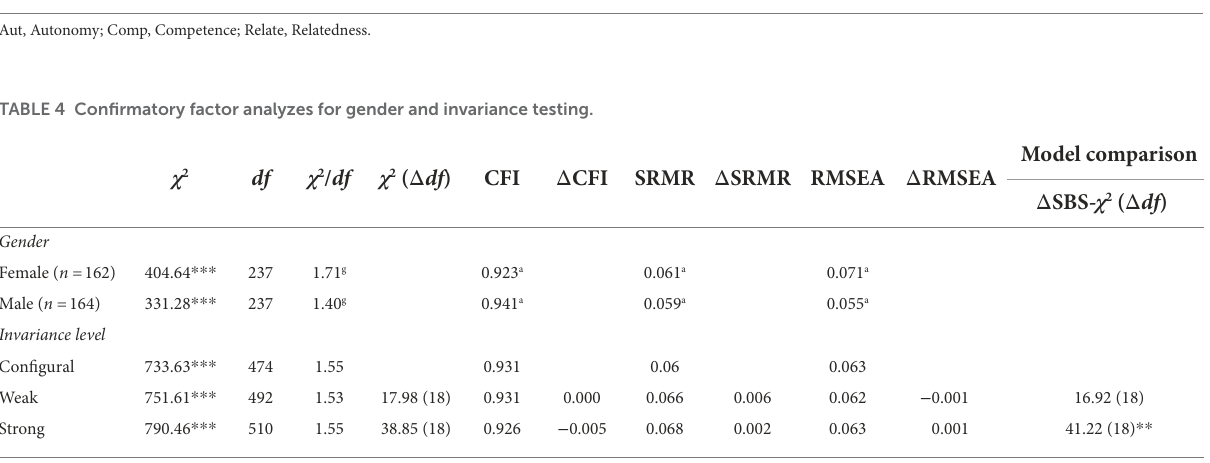
model across gender, measurement invariance of the 6-factor model was tested in a series of multigroup CFAs with three levels of invariance (configural, weak and strong invariance). When calculating the 6-factor model for the two subsamples separately,